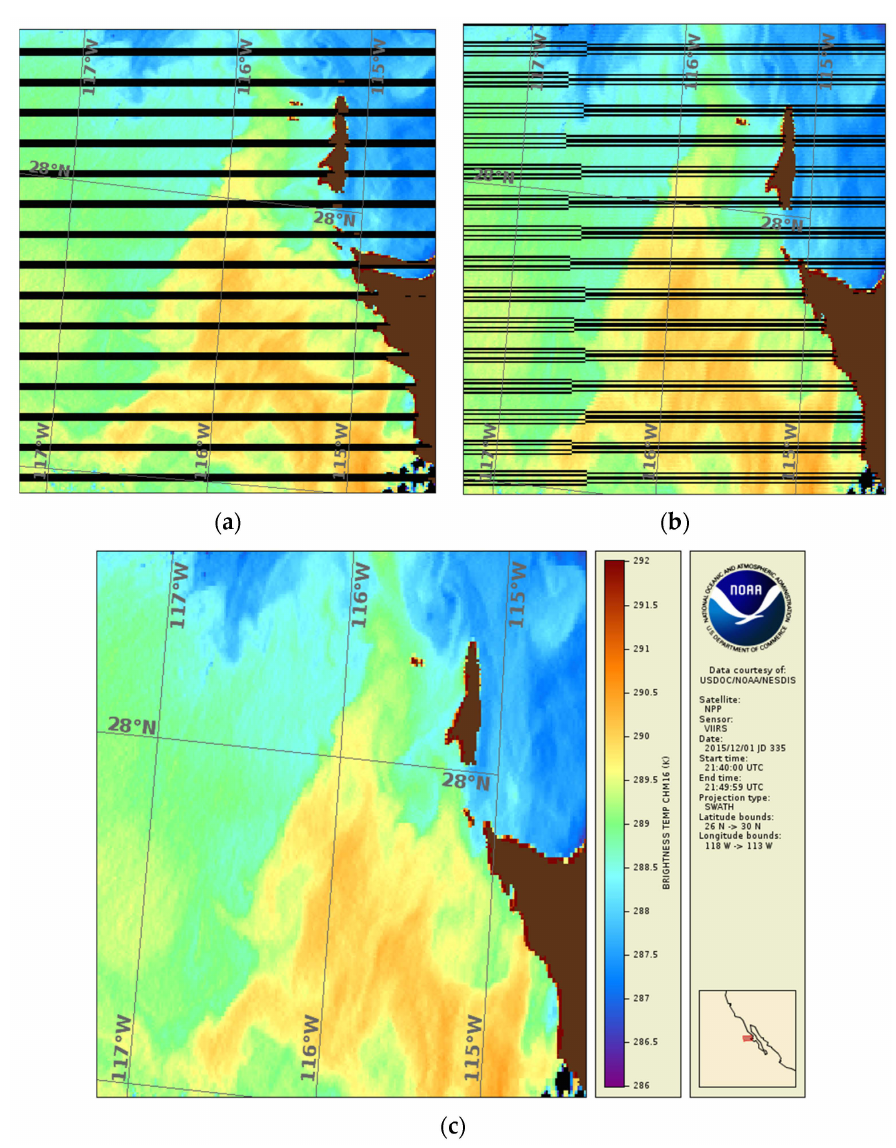
Figure 11. BT at 12 µ m: ( a ) Original; ( b ) Reordered; ( c ) Resampled with missing values